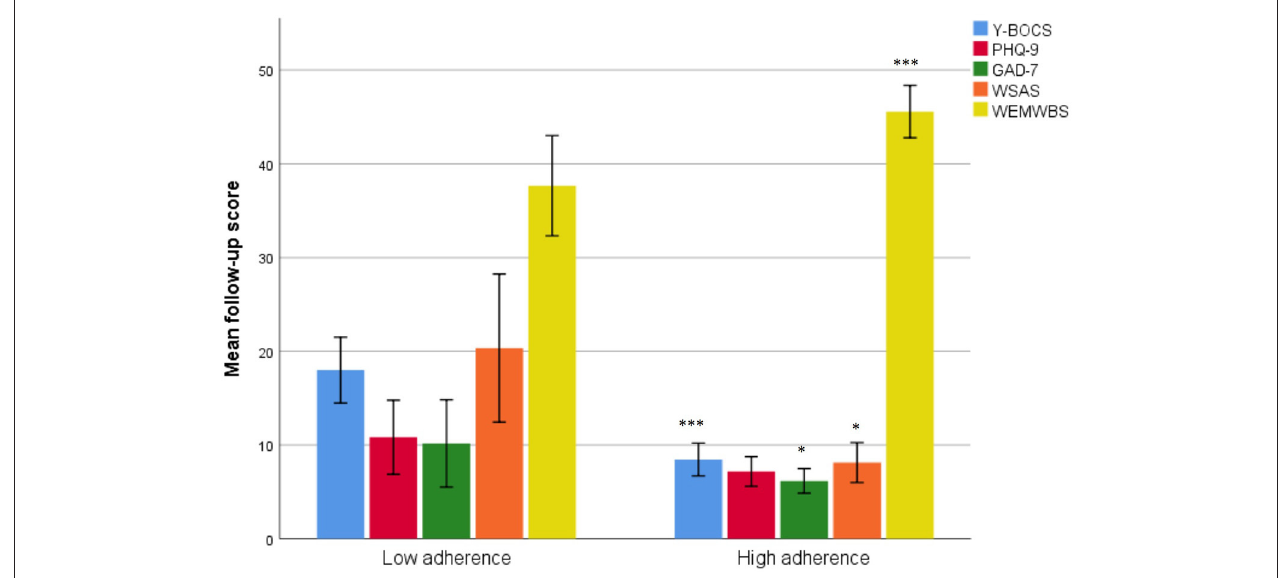
FIGURE 1 | Comparisons between patients rating themselves high or low on quality of exposures attempted. *** < 0.001, * <